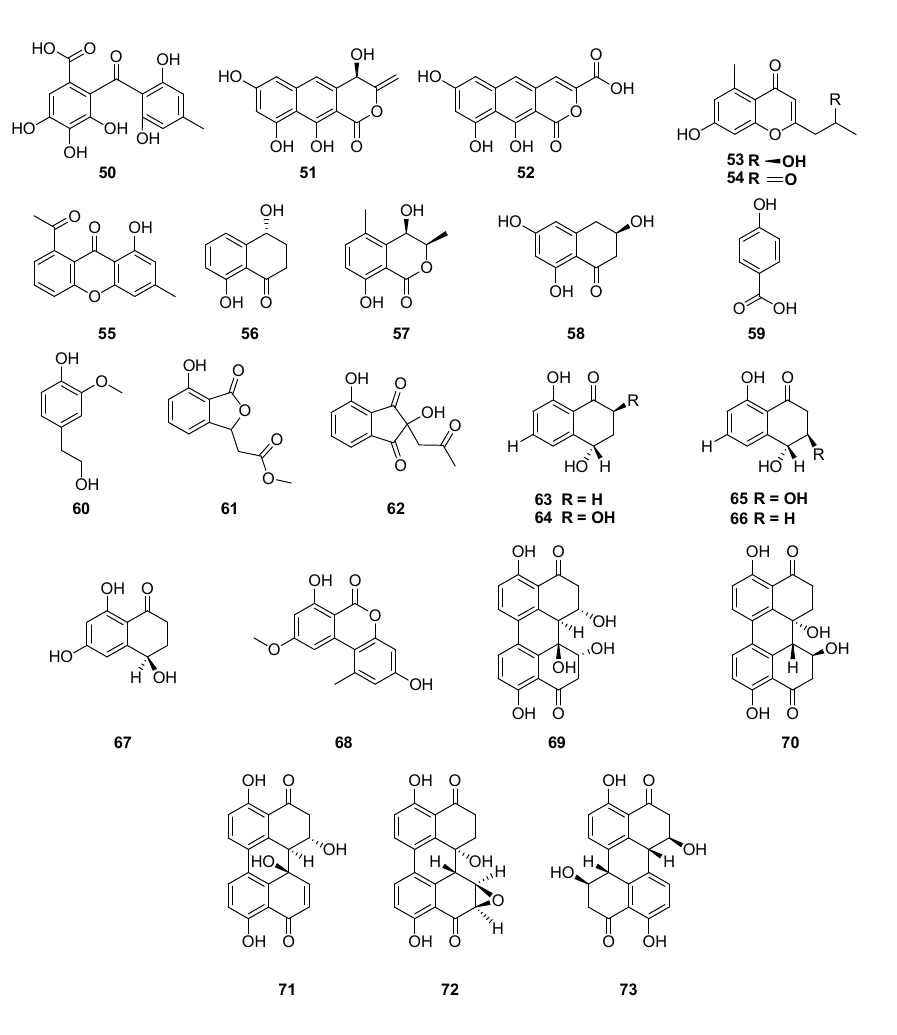
Figure 6. Compounds extracted from endophytic fungus Sporormiella minimoides obtained from Hintonia latiflora